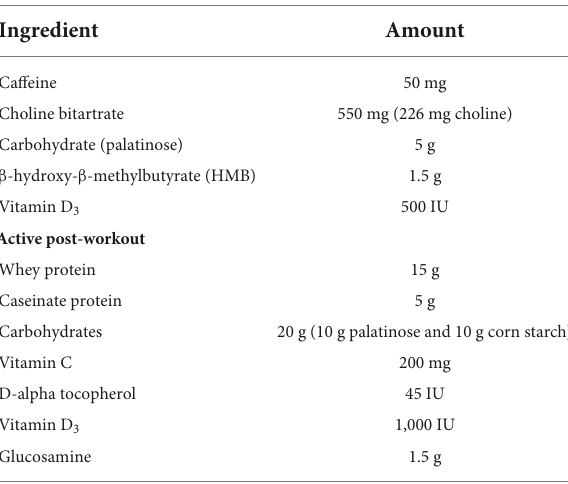
TABLE 2 Multi-ingredient active supplement